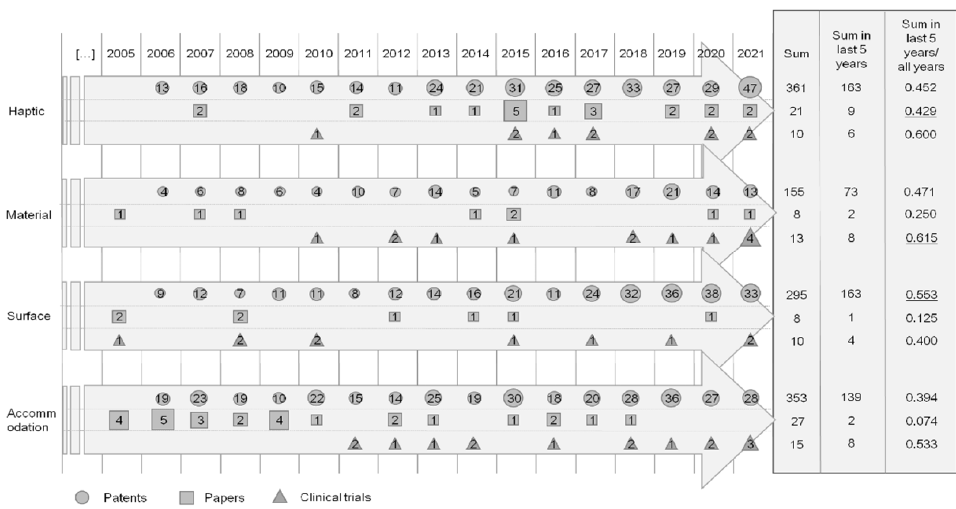
Figure 6. Data lanes for the IOL technology from the patents, papers, and clinical trials.